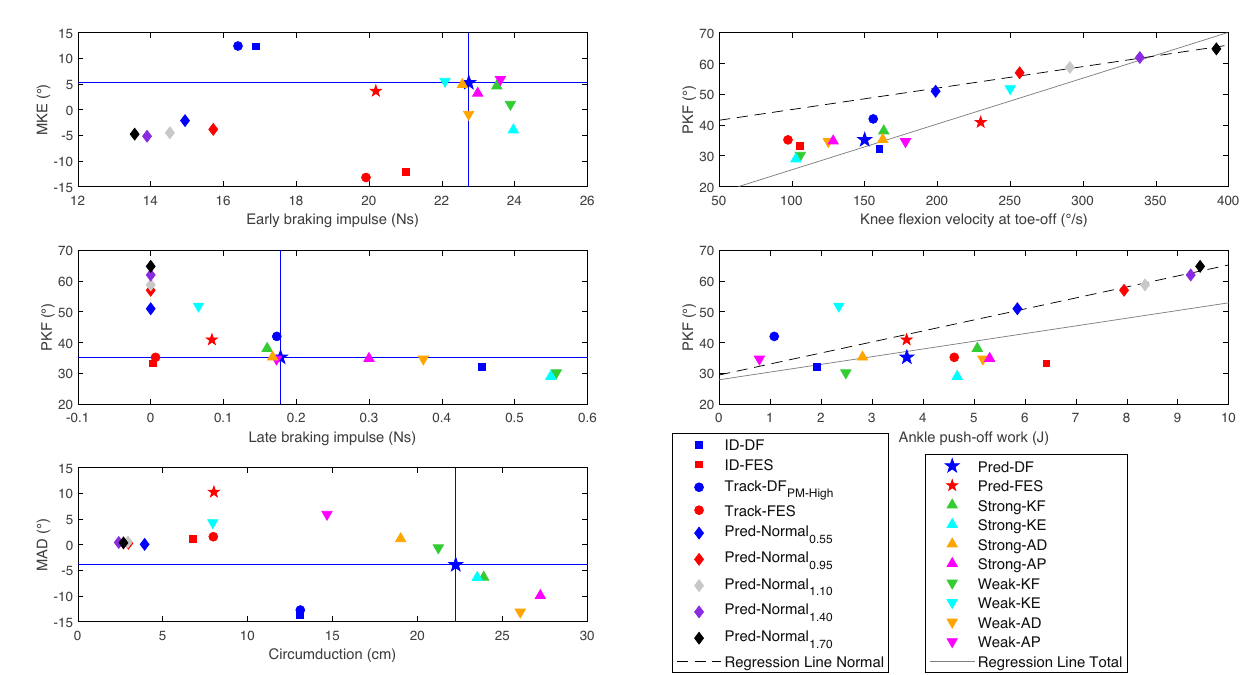
Figure 6. Relationship between MKE and early braking impulse; PKF and knee flexion velocity at toe-off; PKF and late braking impulse; PKF and ankle push-off work; and MAD and circumduction. Only values for the ipsilateral leg are shown. The horizontal and vertical blue lines indicate the values for Pred-DF. The dashed regression line was calculated based on the five Pred-Normal results, while the solid regression line was calculated based on all